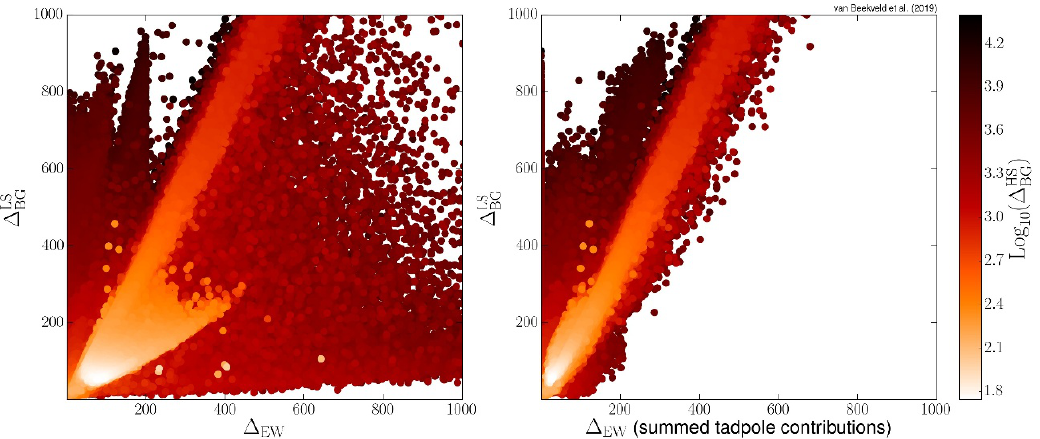
Figure 10 . Left: (cid:1) EW against (cid:1) LS considering each tadpole independently. Right: (cid:1) EW against (cid:1) LS summing up the tadpole contributions before evaluating their size. All computed pMSSM-GUT spectra are shown. Spectra with lower values for log